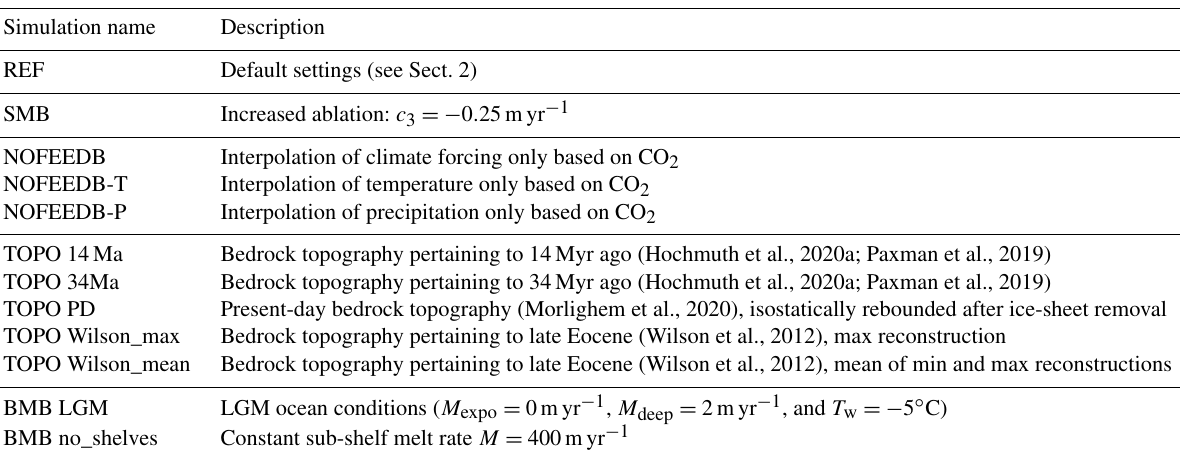
Table 1. Name and description of the experiments carried out. Each experiment comprises 15 simulations, as explained in the main text and listed in Table